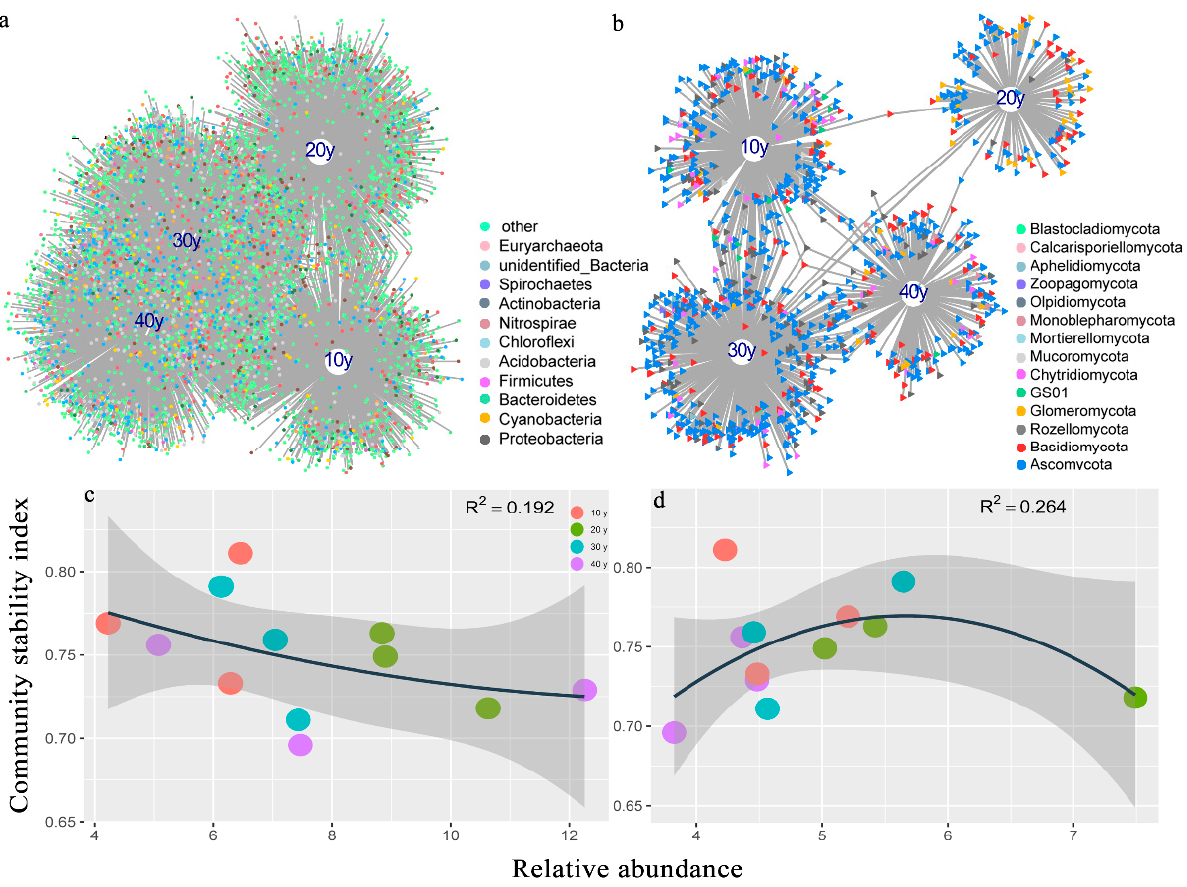
Figure 3. ( a , b ) Bipartite networks displaying specific OTU responses to recovery time in the reed rhizosphere. Bacterial and fungal OTUs were selected using indicator species analysis. Circles represent individual bacterial OTUs, and triangles represent the fungal OTUs that were significantly associated ( p < 0.05) with recovery time (associations shown by connecting lines). OTUs are colored according to their phylum assignment. ( c , d ) Relationship between the assemblage stability index and the relative abundance of bacterial and fungal indicators. (R 2 represents the correlation coefficient, n =12).